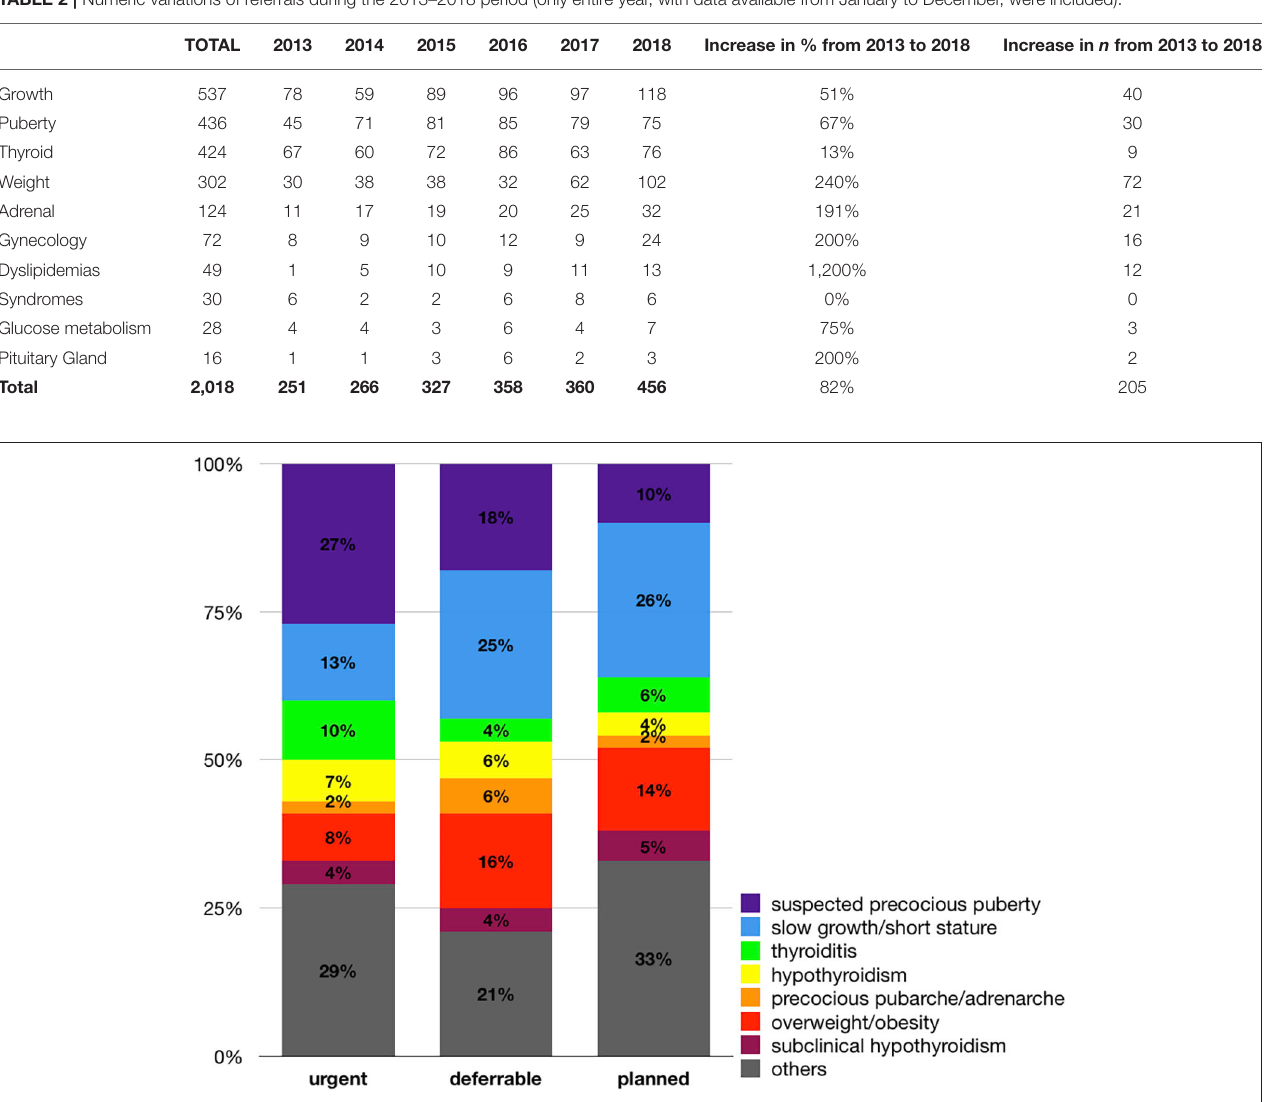
FIGURE 2 | Distribution of referral reasons according to priority ranks. Visits for suspected precocious puberty were more frequent among “urgent” referrals compared to “deferrable” and “planned” ones ( p = 0.007). Visits for slow growth and short stature were instead more frequent in “deferrable” and “planned” referrals compared to “urgent” ones ( p =